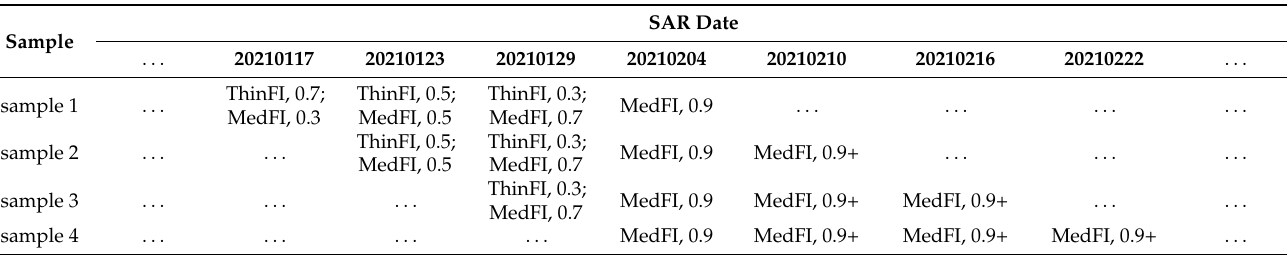
Table 3. The development process of MedFI and its sample